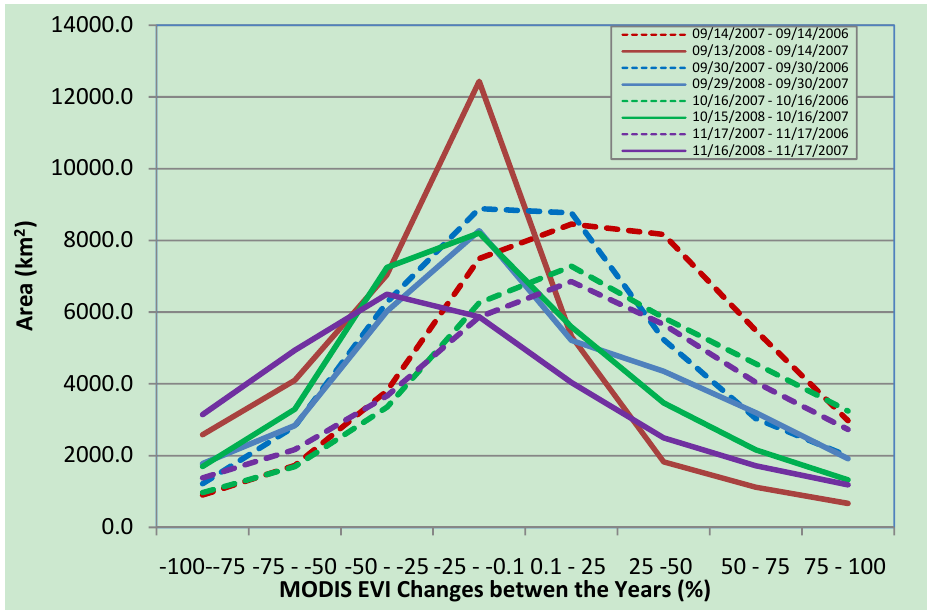
Figure 10. Area of vegetation in the coastal zone by category of MODIS EVI changes between the dates.